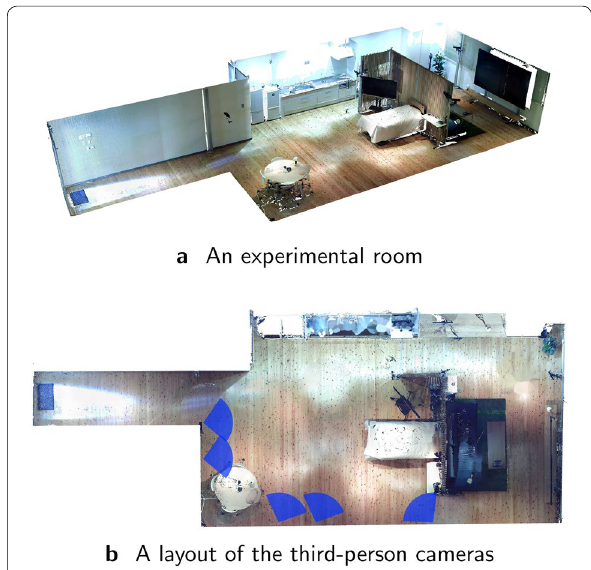
Fig. 6 An experimental room for data collection. a Various pieces of furniture are equipped such as tables, chairs, a bed, a tv, and kitchen facilities. b The blue sectors denote the positions of the third-person cameras